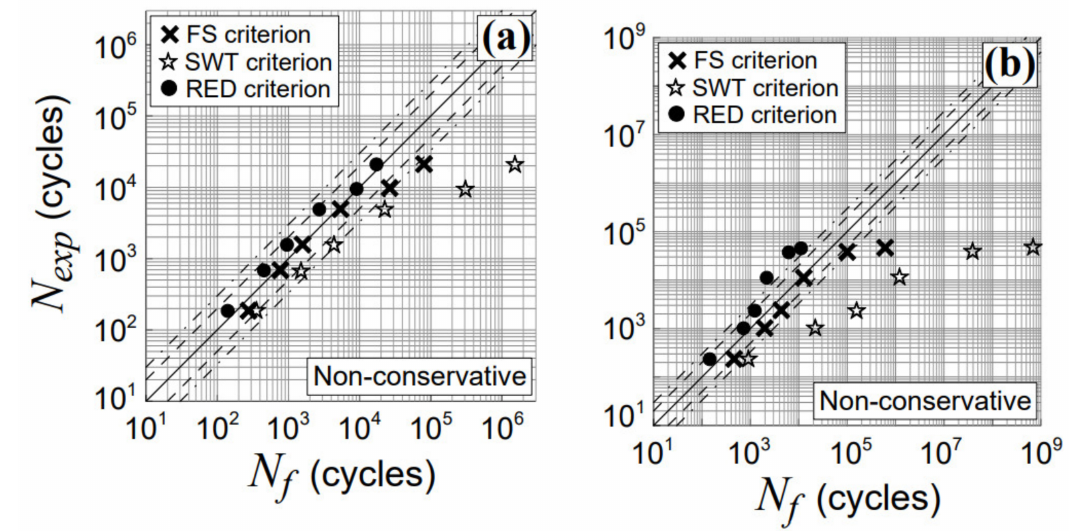
Figure 13. Experimental and estimated lifetimes obtained for TC4 titanium alloy using the FS criterion [47] and the SWT criterion [48] for non-proportional tests with a phase shift, β , equal to ( a ) 45 ◦ (Nos.T7–T12, in Table 2) and ( b ) 90 ◦ (Nos.T13–T18, in Table